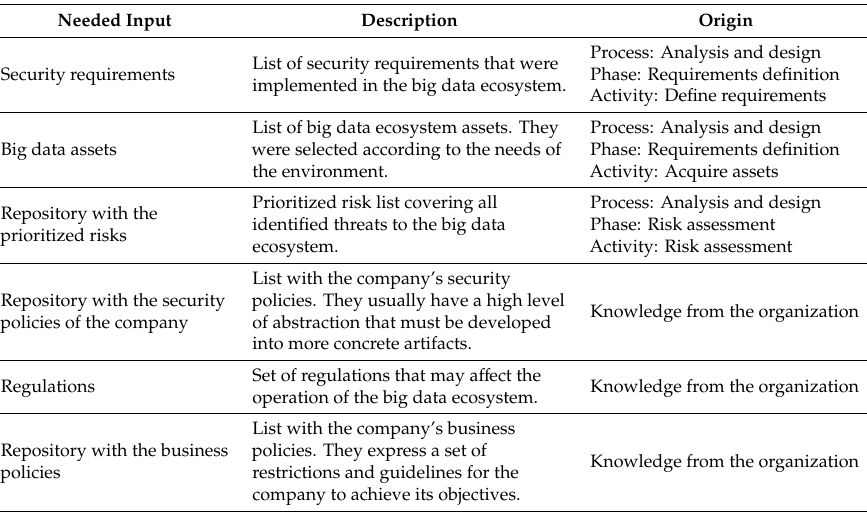
Figure 3. Processes and phases to ensure the security of big data. Table 2. Inputs obtained previously and needed for the